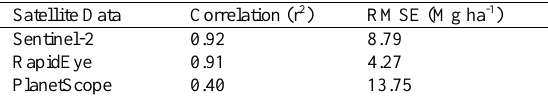
Table 7. Result of accuracy assessment through regression of the predicted AGB raster data and the field validation